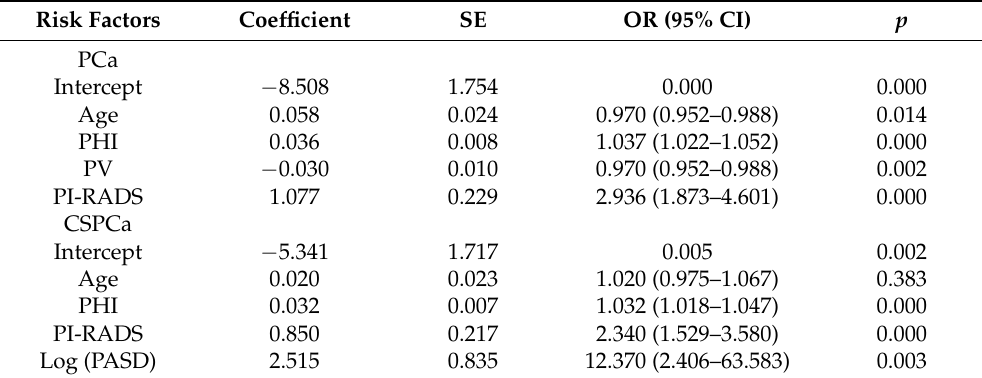
Table 5. Detailed information about the predictive model used to calculate the probability of